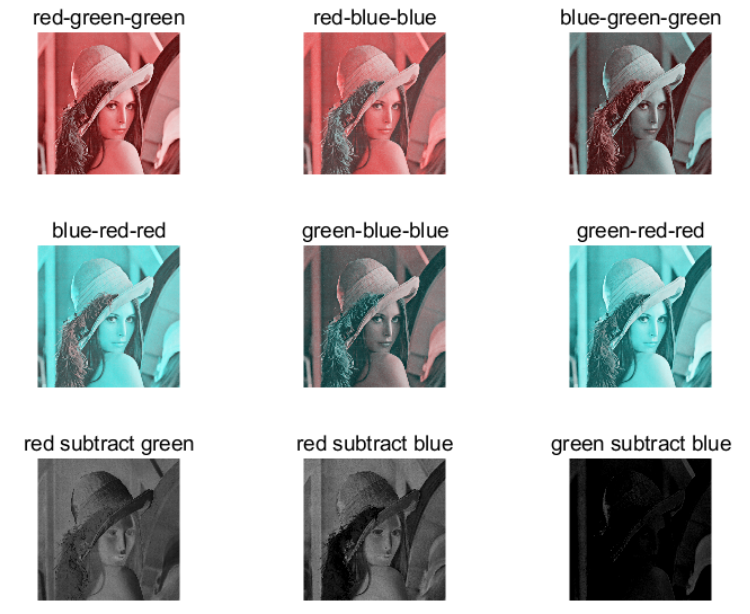
Figure 5. RGB channels combination and the difference between